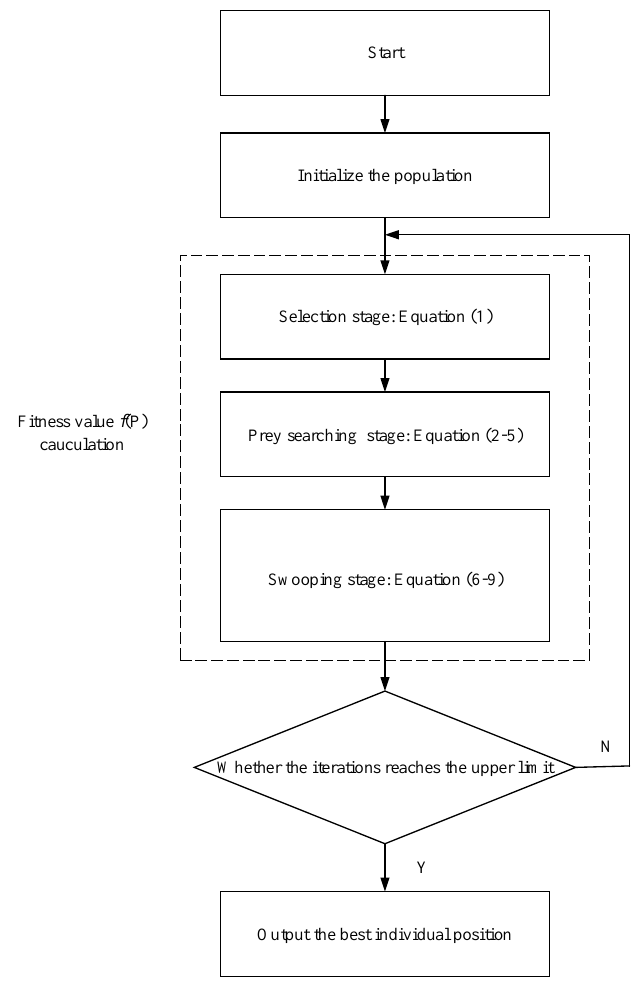
Figure 1. Process of traditional